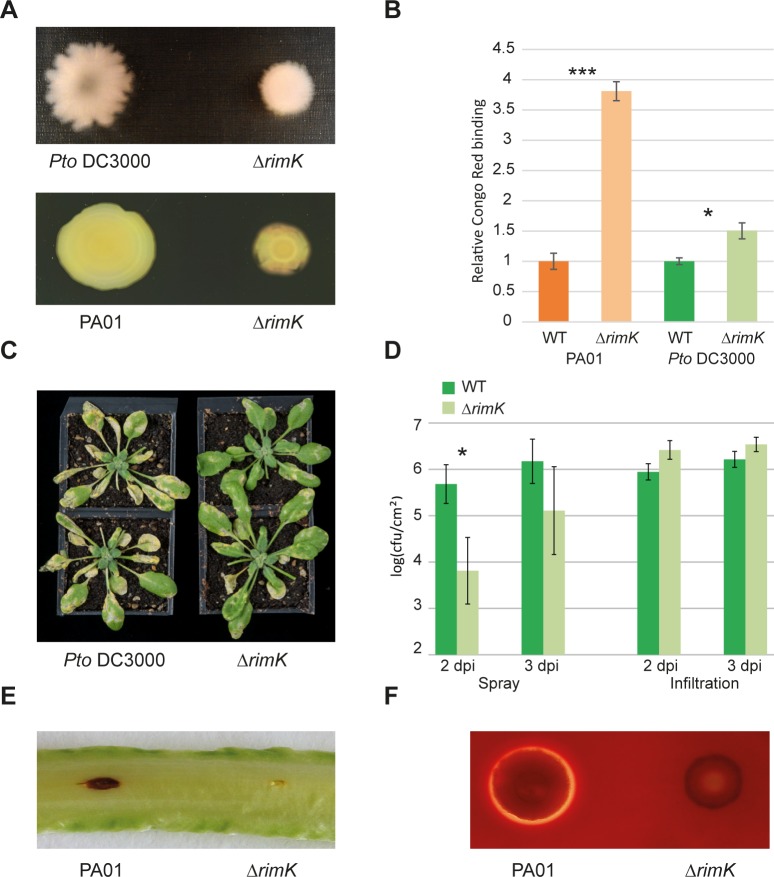
RimK is important for P. syringae and P. aeruginosa plant infection.2A. Swarming motility of Pto DC3000 and PA01 ΔrimK relative to their respective WT strains. 2B. Congo Red binding of Pto DC3000 and PA01 ΔrimK compared with their respective WT strains. 2C. Representative spray-infected Arabidopsis Col-0 plants 4 days post-infection with Pto DC3000 WT/ΔrimK. Disease symptoms are less marked with ΔrimK infection. 2D. log (P. syringae CFU per cm2 leaf tissue) recovered from Arabidopsis Col-0 plants infected with Pto DC3000 WT or ΔrimK, 2 and 3 days post-infection (dpi). The infection method in each case is stated beneath the graph. 2E. Lettuce leaf infections with P. aeruginosa WT/ΔrimK strains. Lesions photographed after 5 days. 2F. β-hemolysis by P. aeruginosa WT/ΔrimK strains after 24 h growth on horse blood agar.